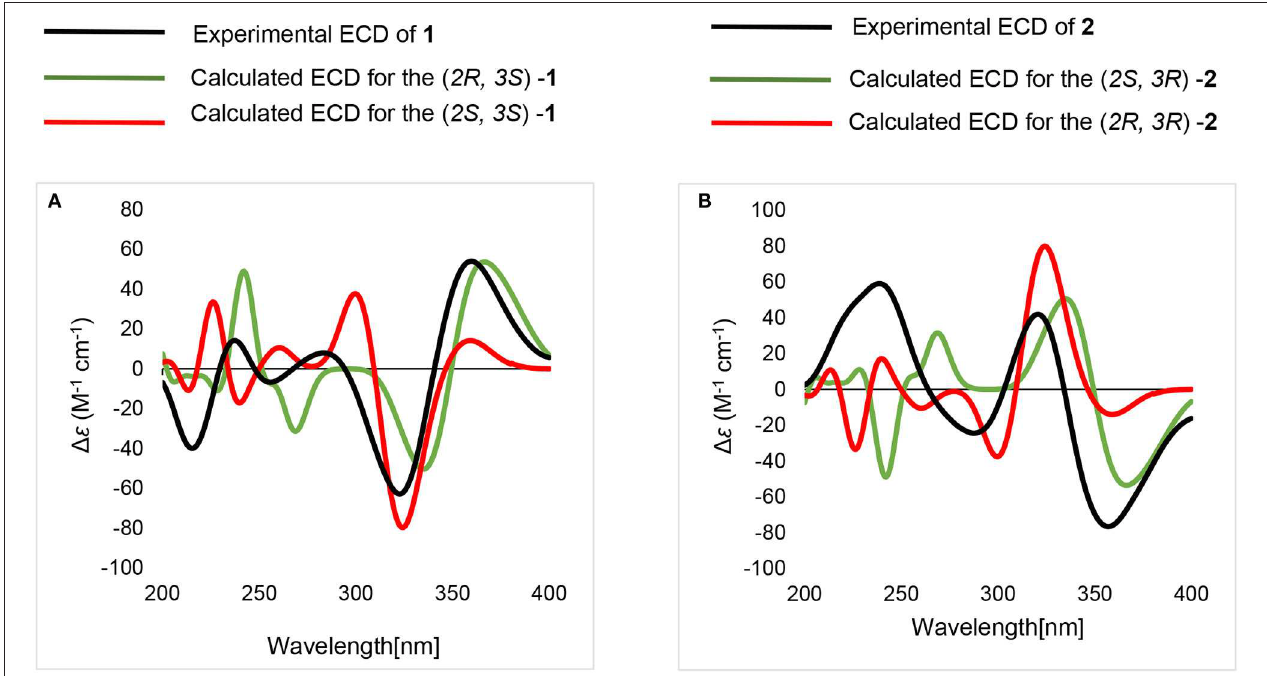
FIGURE 4 | Calculated and experimental ECD spectra. (A) calculated and experimental ECD of (2 R , 3 S )- 1 , (2 S , 3 S )- 1 . (B) calculated and experimental ECD of (2 S , 3 R )- 2 , (2 R , 3 R )- 2